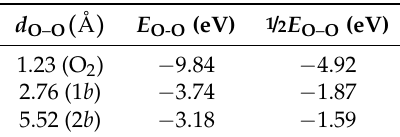
Table 1. Bond lengths and total and half energies of O–O complexes in the vacuum. The top row corresponds to the stable O 2